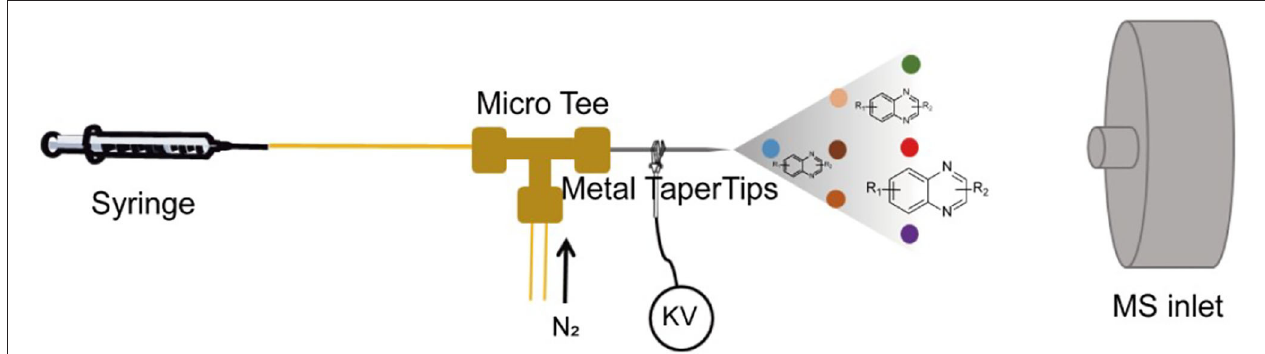
FIGURE 1 | The single-barrel microdroplet device for the synthesis of